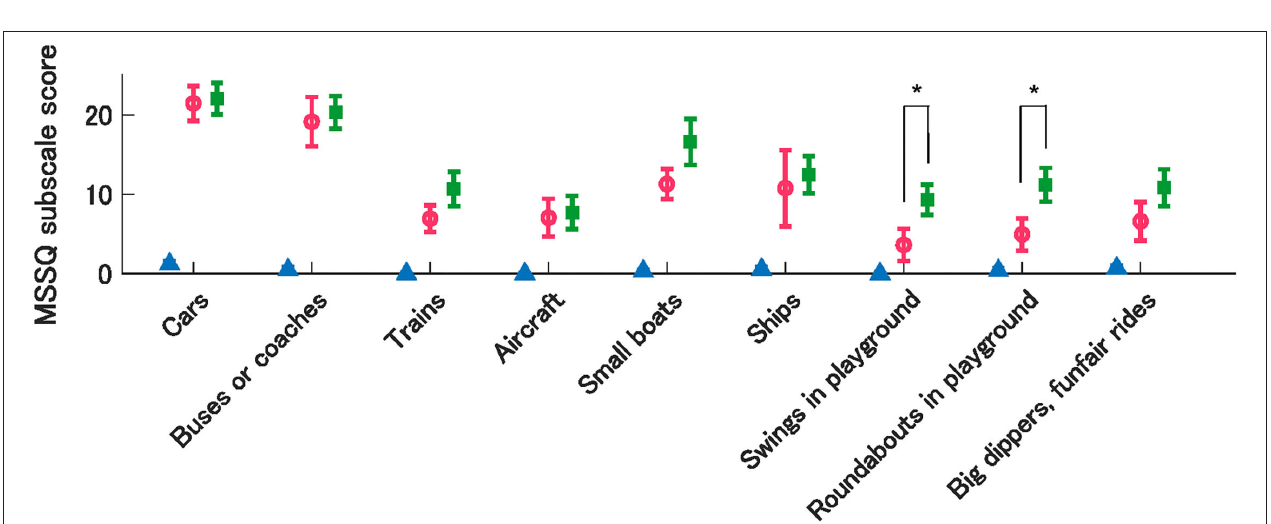
FIGURE 6 | Mean MSSQ sub-scores by vehicle types from the control group (triangle) and MSS subgroups with high (circle) and low (rectangle) OCR asymmetry. Error bars denote SEM. *indicate significant differences between MSS subgroups.